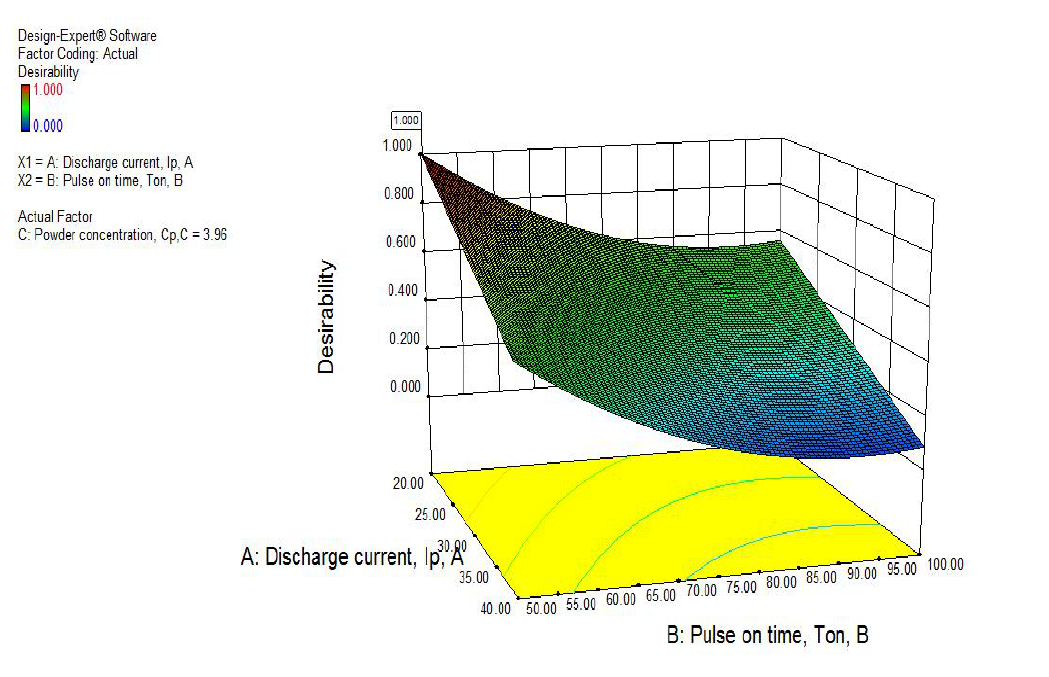
Figure 7: Three dimensional surface graph for solution